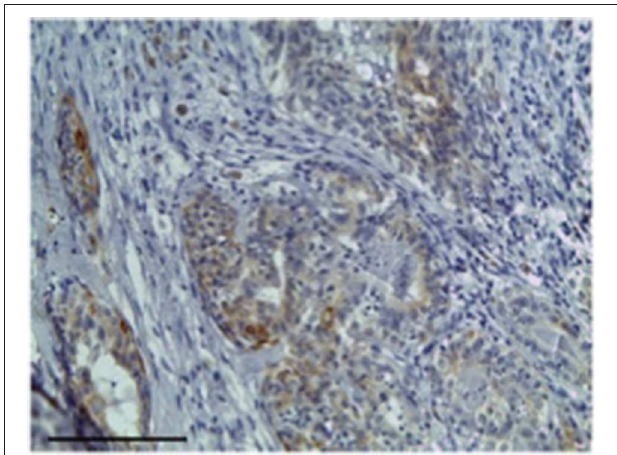
FIGURE 4 | The figure shows the immunohistochemical reactivity classified as strong immunostaining primary antibodies against TP located in the cytoplasm of the neoplastic mammary epithelial cells, Bar 100 µ m.